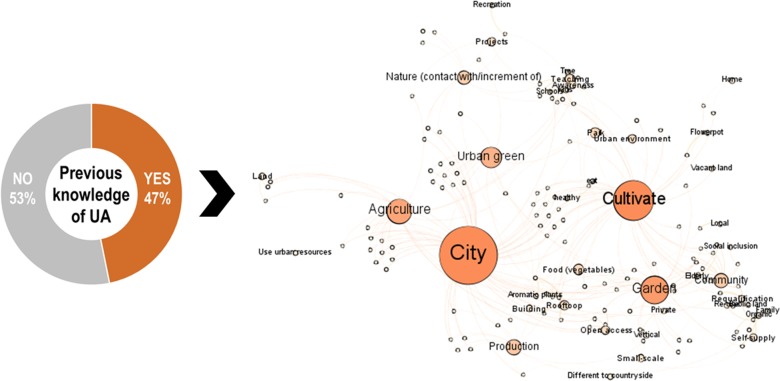
Participants’ previous knowledge on UA [Q2]: Have you already heard about the term „urban agriculture?” and network of the concepts employed for the definition of UA [Q3] “How would you explain/define UA? (for participants with previous knowledge) and [Q3b]: What do you think UA is like? (for participants without previous knowledge).